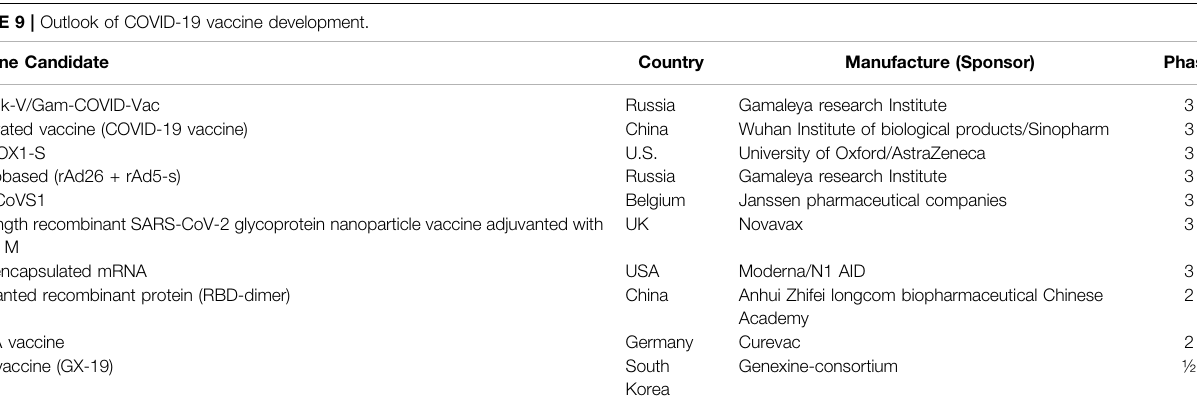
TABLE 9 | Outlook of COVID-19 vaccine